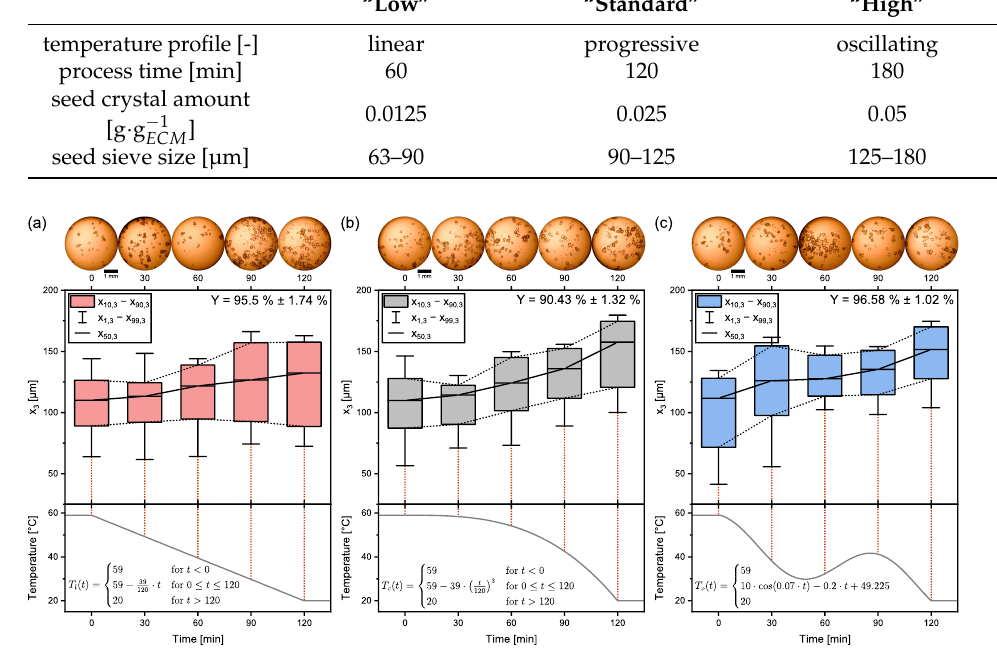
Figure 7. Boxplots of the crystallization of sucrose for the discussed temperature profiles. ( a ) shows the linear, ( b ) the progressive, and ( c ) the oscillating temperature profile. Yields are indicated in the top right. Quantiles are averages from triple experiments. The temperature profiles are plotted in the bottom panels. Process time t process = 120min, seed crystal amount ω SC = 0.025g · g − 1 size: